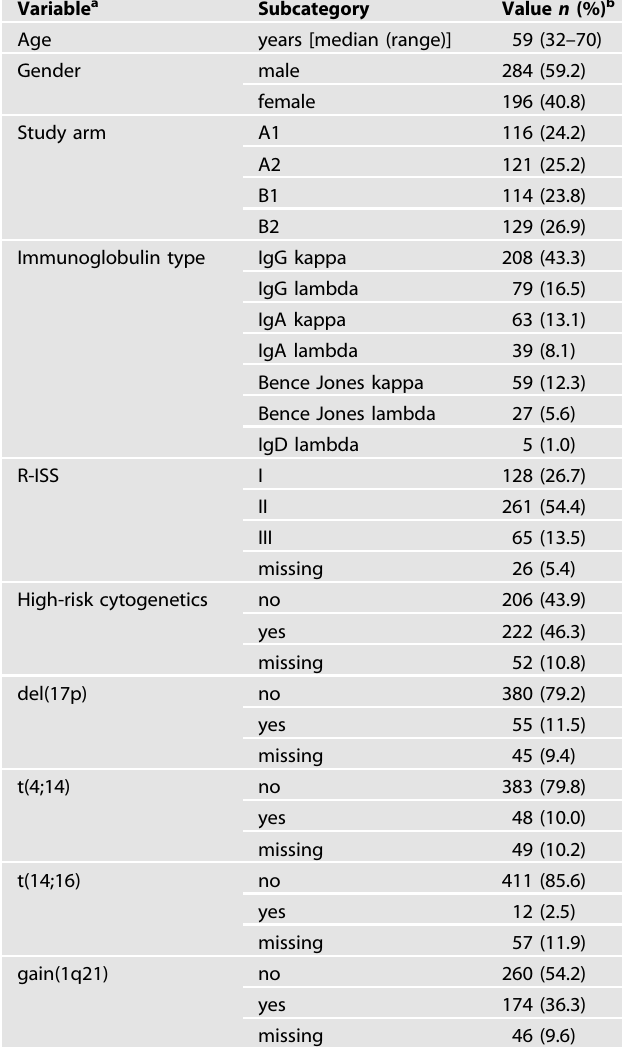
Table 1. Baseline characteristics of the analyzed cohort within the GMMG-MM5